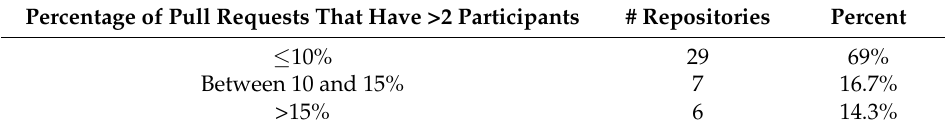
Table 7. Percentage of Pull Requests that have more than two participants involved.